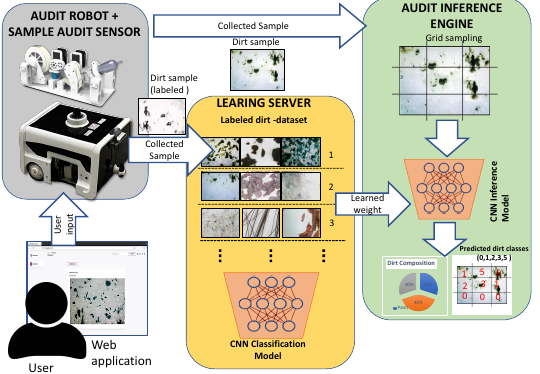
Figure 1. Proposed overview for domestic dirt collection using autonomous